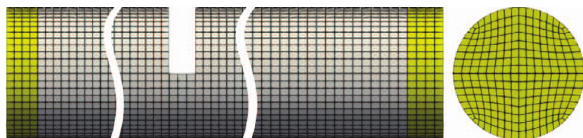
Figure 12. CA mesh with consisting of a fl uid region (grey) and adjacent PML regions